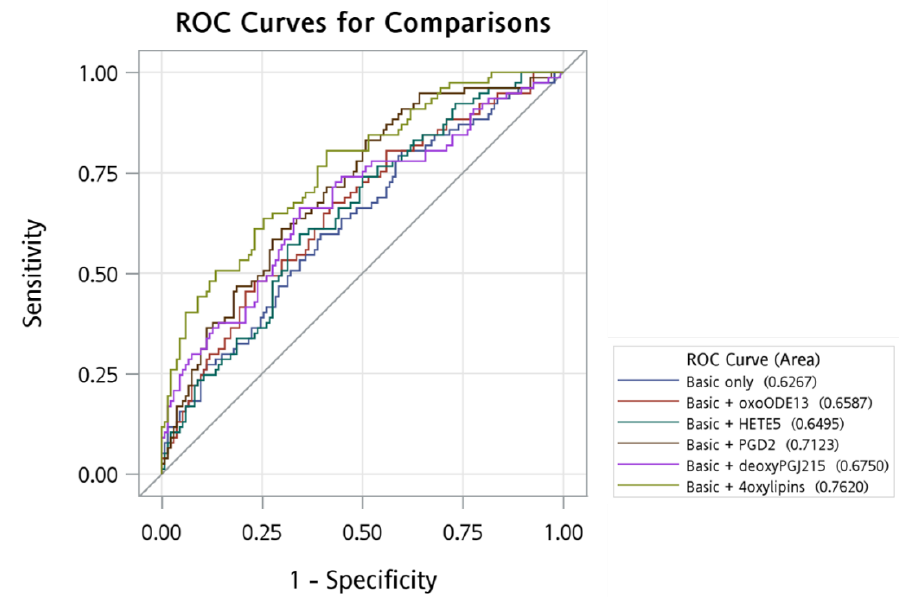
Figure 2. ROC curve of basic variables and oxylipins. Figure 1. ROC curve of basic variables and